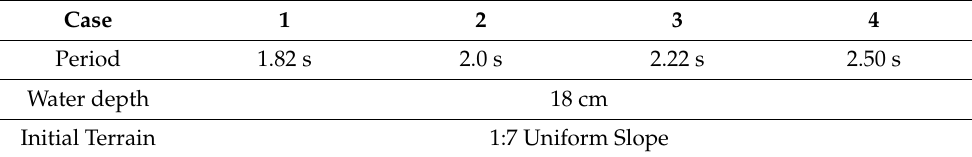
Table 3. Experimental